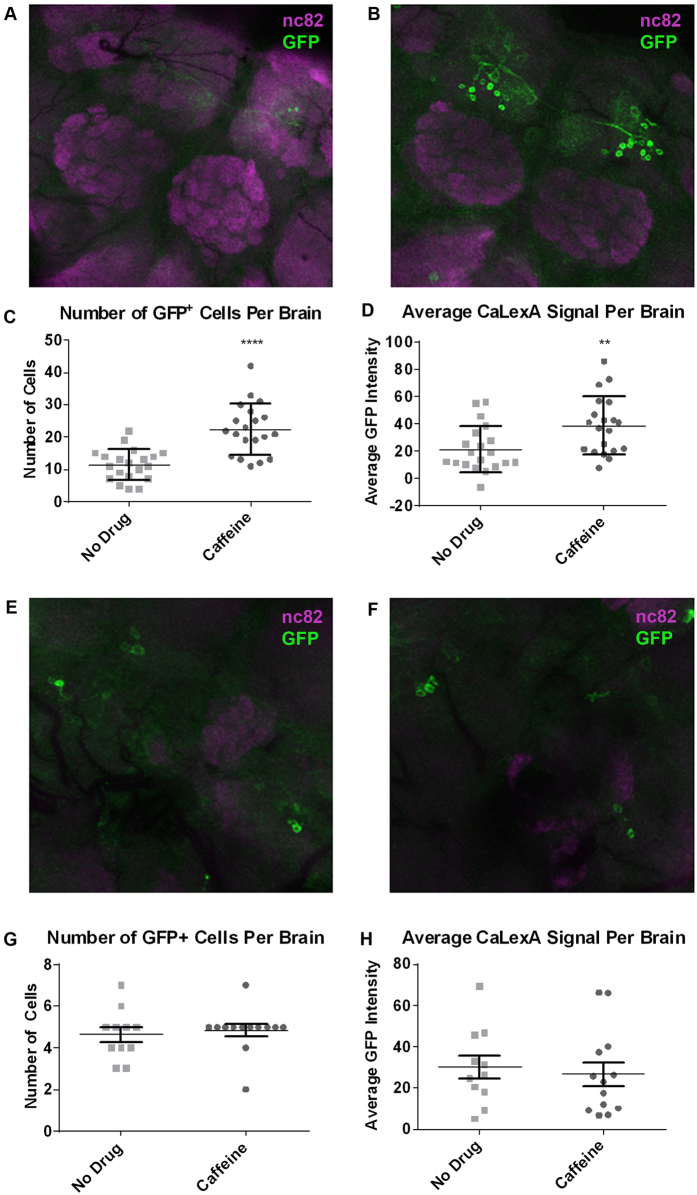
Caffeine causes increased activity of PAM cluster neurons.Immunostaining of the CaLexA signal (GFP, green) and neuropil (nc82, magenta) in brains of flies expressing the CaLexA construct under the control of the 0273-Gal4 driver to visualize PAM cluster neurons or the broader TH-Gal4 driver to visualize PPM3 cluster neurons. Flies were fed either (A,E) drug-free food or (B,F) food containing 0.5 mg/ml caffeine for 24 hours prior to dissection and staining. The GFP intensity was quantified on a cell-by-cell basis in each brain. (C,G) The average cell intensity for each brain is plotted for drug-free and caffeine-fed groups. (D,H) The number of visible GFP-positive cells in each brain is plotted for drug-free and caffeine-fed groups. Large horizontal line reflects the average, and error bars show standard deviation.